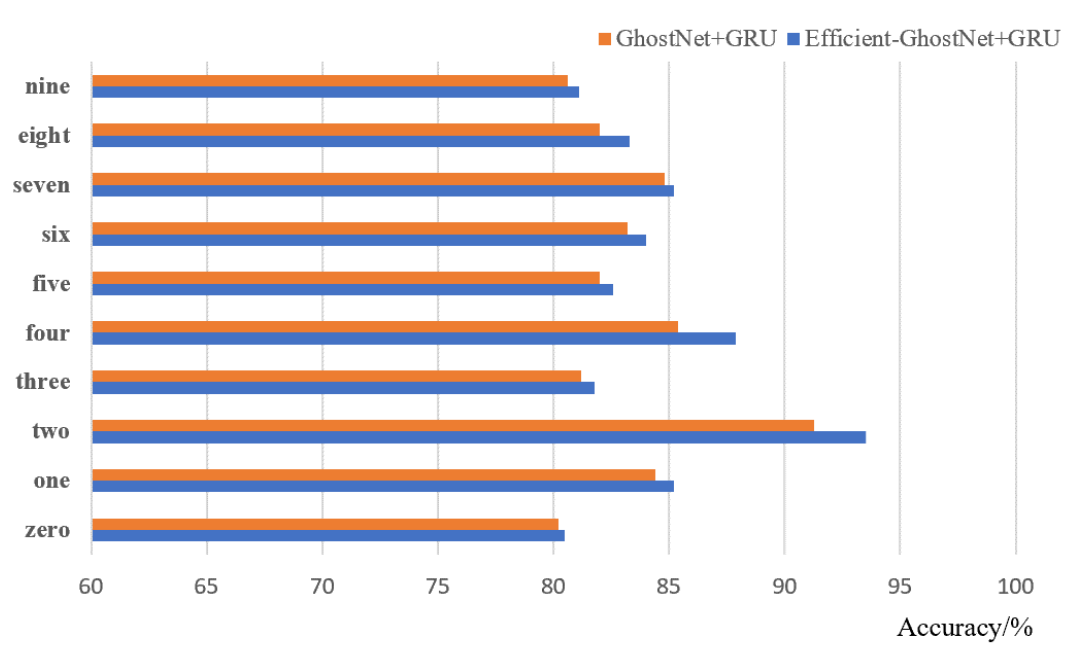
Figure 10. Comparisons of recognition accuracy between two networks. Table 3. Performance comparison of each model with the GRID